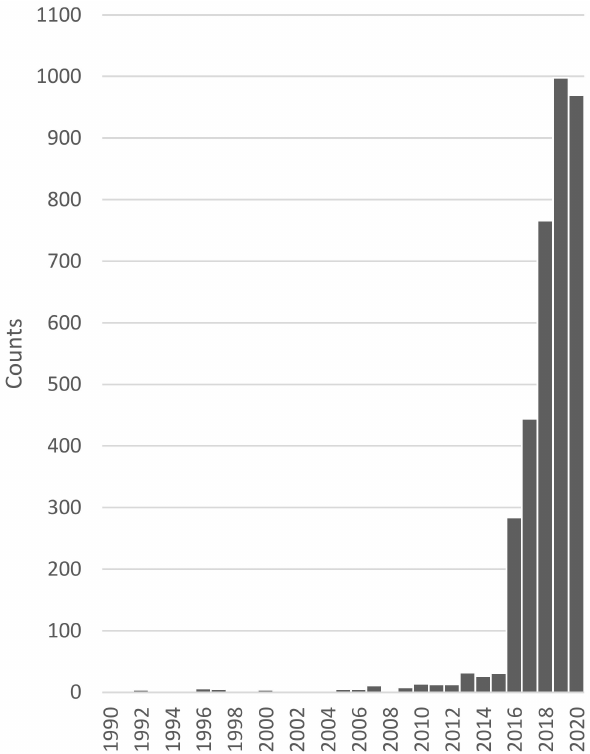
Figure 1. Number of news articles, publications and conferences connected to the topic of AI in diagnostic medicine over time. Data was collected and is provided by the Association for the Advancement of Artificial Intelligence